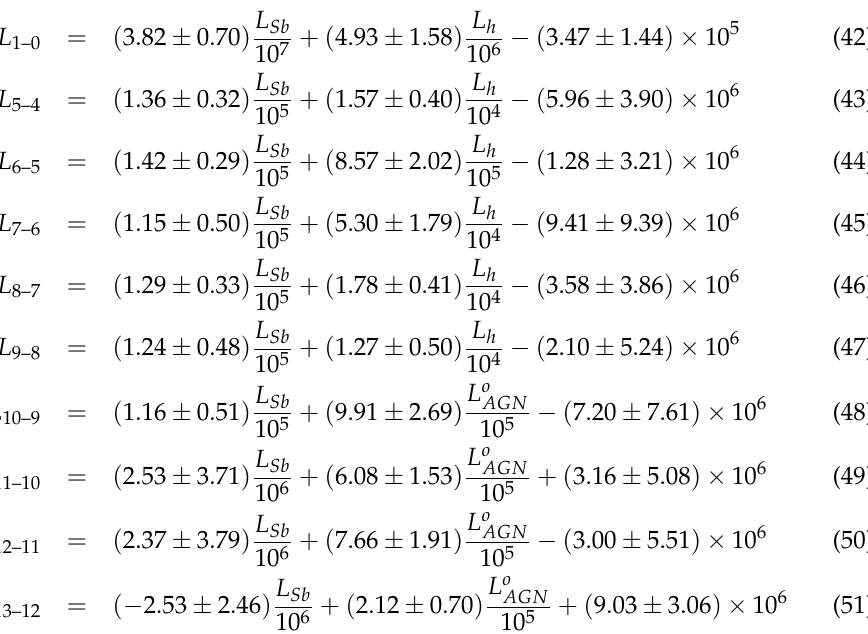
Figure 5. We do not present fits of the form: L CO = α L Sb + β L AGN + γ L h as they proved challenging to constrain with the number of objects in our sample.